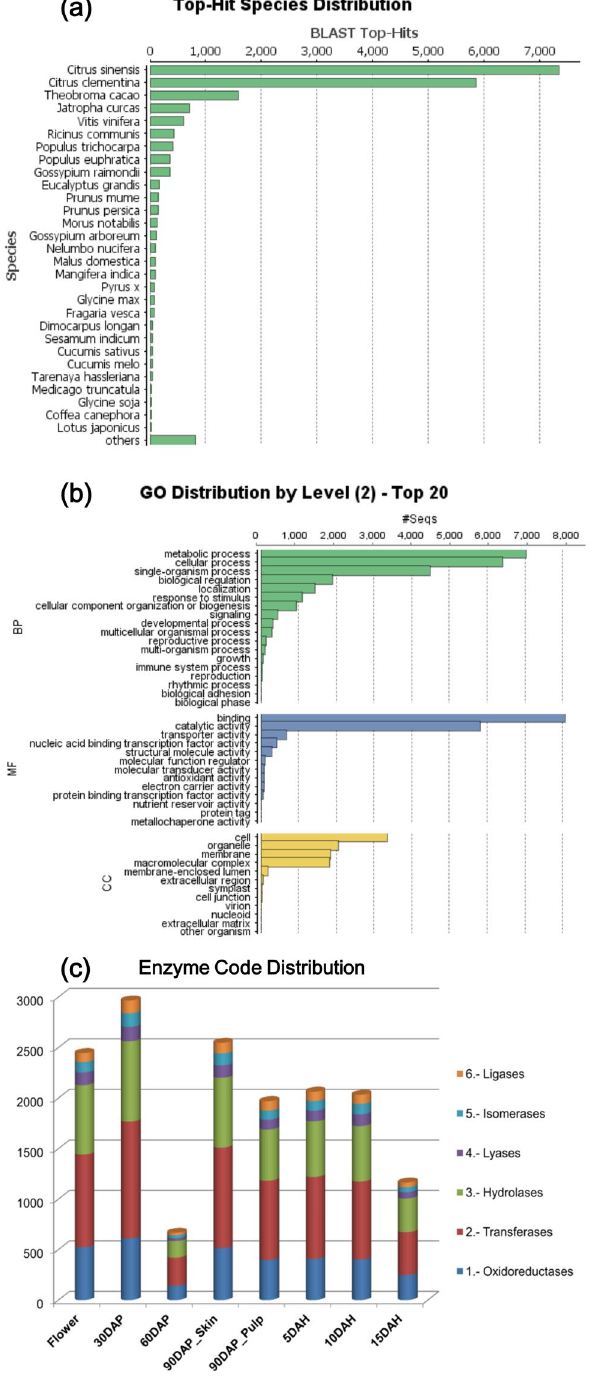
Figure 1. Blast statistics showing ( a ) distribution of top hit species, ( b ) distribution of top gene ontologies from BP: biological processes, MF: molecular functions and CC: cellular components and ( c ) Enzyme code distribution: number of transcripts (Y-axis) encoding six classes of enzymes through various stages of Alphonso mango fruit development and ripening